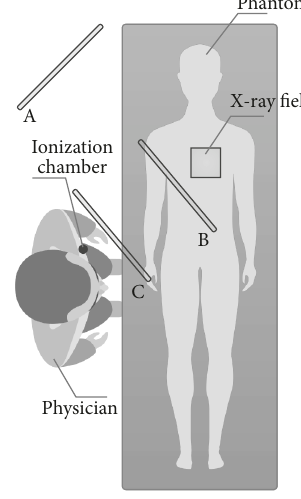
Figure 3: Different positions of the ceiling-mounted shielding for cardiology.